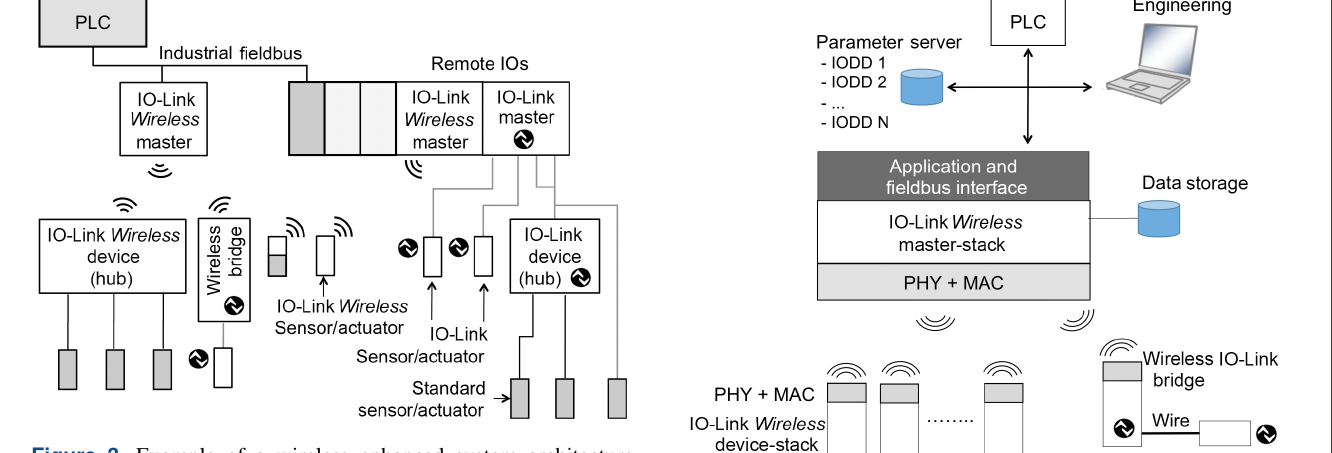
Figure 3. Example of a wireless enhanced system architecture based on IO-Link according to (IO-Link Community, 2016).